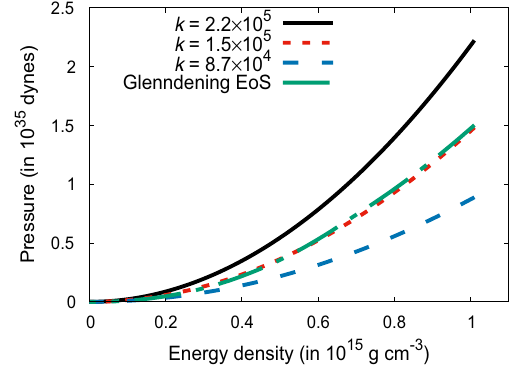
Fig. 2 Pressure, as a function of energy density, plotted for four dif- ferent EoS. The black solid curve describes the stiff polytropic EoS. The red short dashed curve is for the polytrope with moderate stiffness. The blue dashed curve is for soft polytope, and the green dot-dashed curve is for the Glendenning EoS. The value of δ for the polytropes is the same ( δ = 2) only the value of k